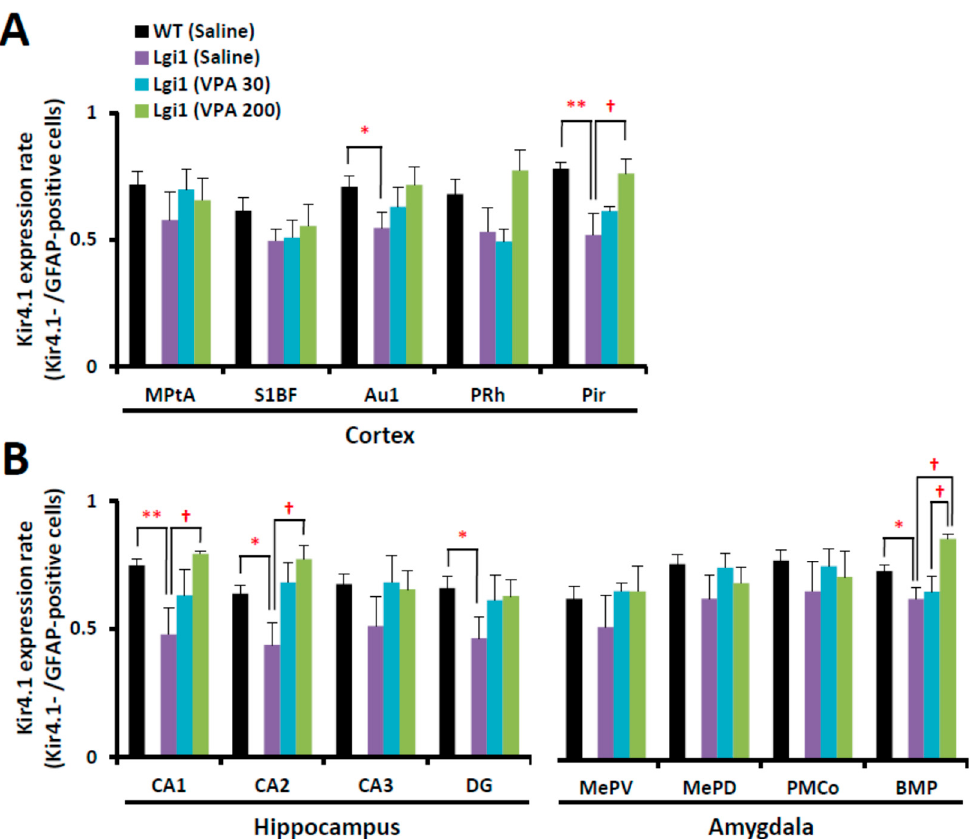
Figure 7. Expression changes in astrocytic Kir4.1 with treatment of valproic acid (VPA). Kir4.1 expression ratios of wild-type rats treated with saline and Lgi1 mutant rats treated with saline or VPA (30 mg/kg or 200 mg/kg) are shown in each region of the cortex ( A ), hippocampus, and amygdala ( B ). The Kir4.1 expression rate was expressed as the ratio of Kir4.1-IR-positive cells to GFAP-IR-positive cells in each region. Each point represents the mean ± S.E.M. of four to six animals. * p < 0.05, ** p < 0.01, significantly different from wild-type rats treated with saline. † p < 0.05, significantly different from Lgi1 mutant rats treated with saline.